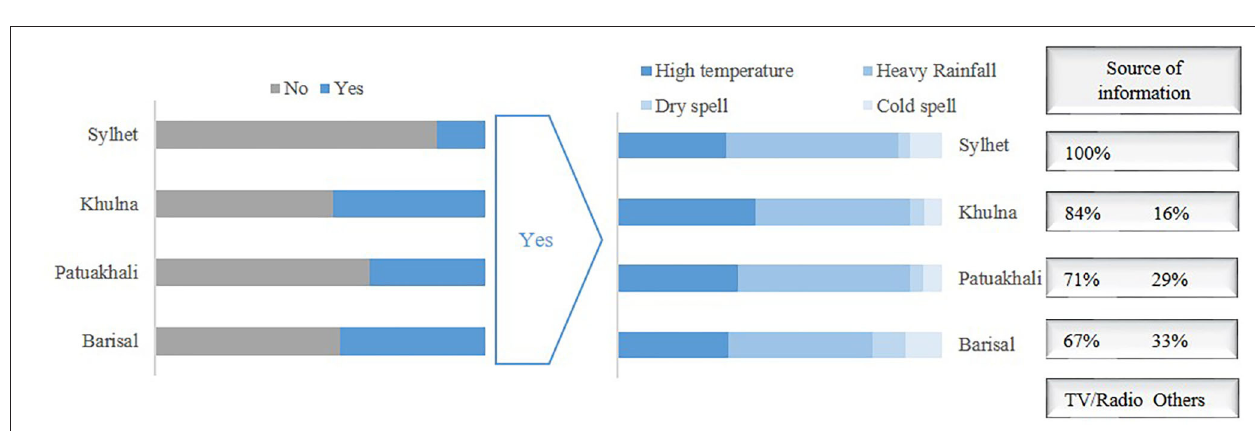
FIGURE 6 | Fish-farmers’ responses on difficulties encountered in aquaculture resulting from perceived climatic variability.